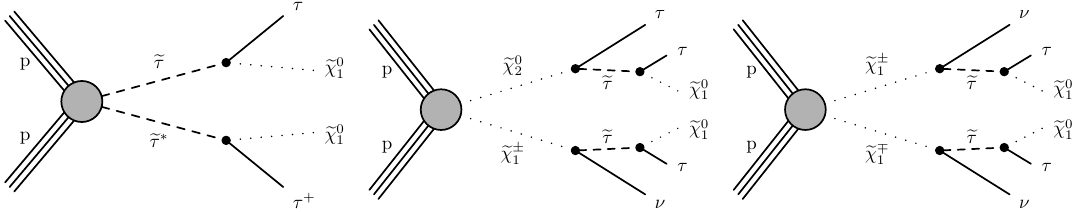
Figure 1. Diagrams for the simpli(cid:12)ed models studied in this paper: direct (cid:28) pair production followed by each (cid:28) decaying to a (cid:28) lepton and (cid:31) 0 (left), and chargino-neutralino (middle) and 1 chargino pair (right) production with subsequent decays leading to (cid:28) leptons in the (cid:12)nal state. e e e require the presence of signi(cid:12)cant missing transverse momentum, which can arise from the presence of stable neutralinos produced at the end of the SUSY particle decay cascades, as well as from the neutrinos produced in (cid:28) lepton